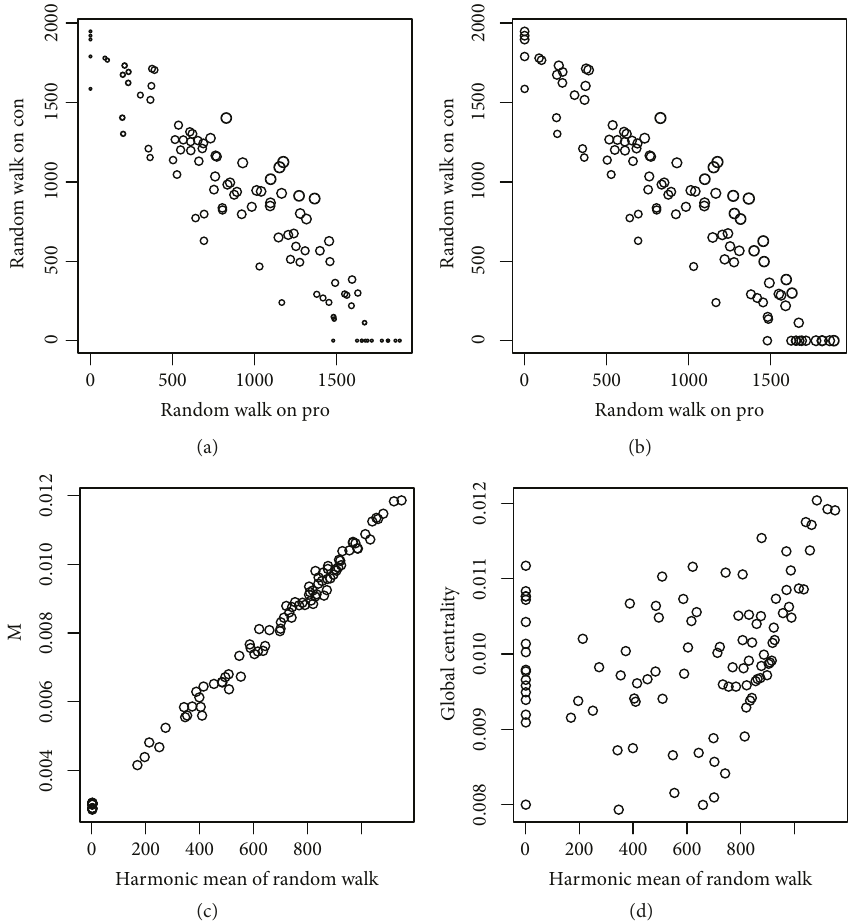
Figure 5: Comparison of mediation centrality and global centrality against random walk residence times in Simulation 1. Each individual is represented by a dot. (a) Random walk residence times for pro and con reasons. Dot size represents mediation centrality value. (b) Random walk residence times for pro and con reasons. Dot size represents global centrality. (c) Mediation centrality against random walk residence times. (d) Global centrality against random walk residence